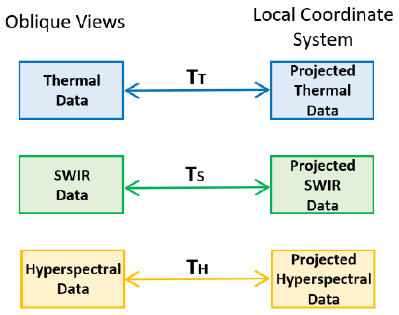
Figure 2: Establishing correspondences among the Field of Views. The perspective transformations and inverse perspective transformations are estimated and employed to convert coordinates to the Local Coordinate System (LCS) from the oblique views of all image planes and vice versa.